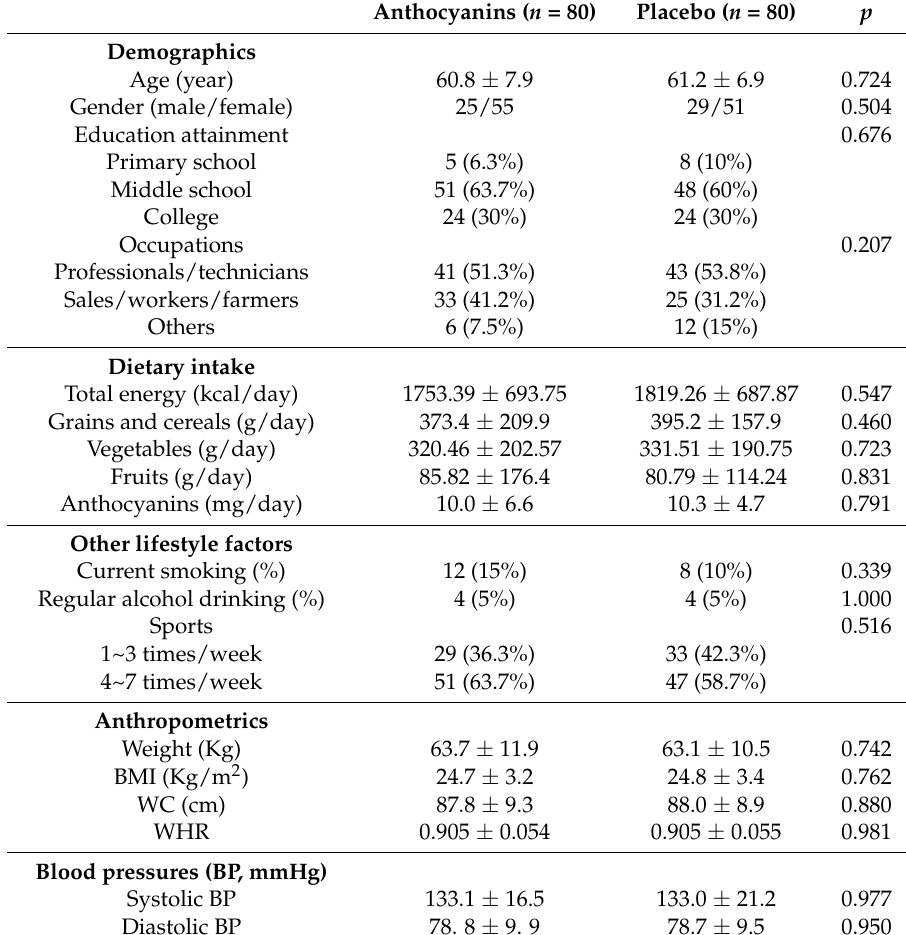
Table 1. Baseline characteristics of the 180 participants in anthocyanins and placebo